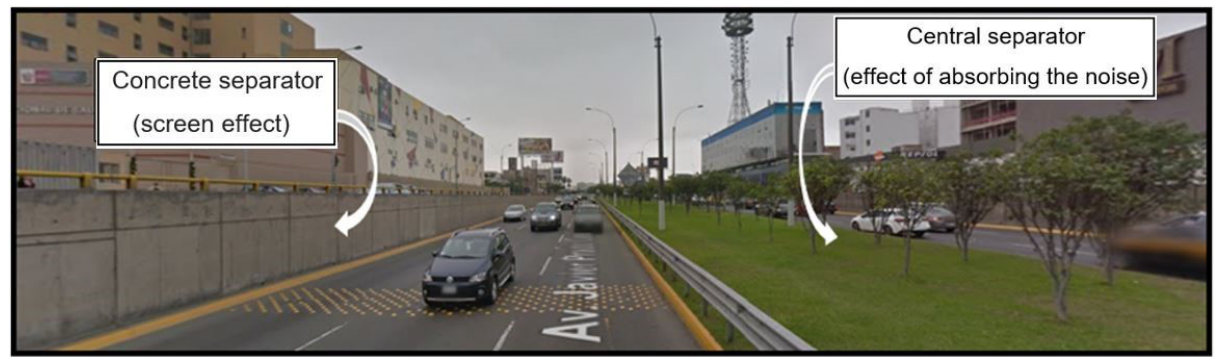
Figure 5: Panoramic view of Javier Prado Avenue in front of the San Borja’s Children’s